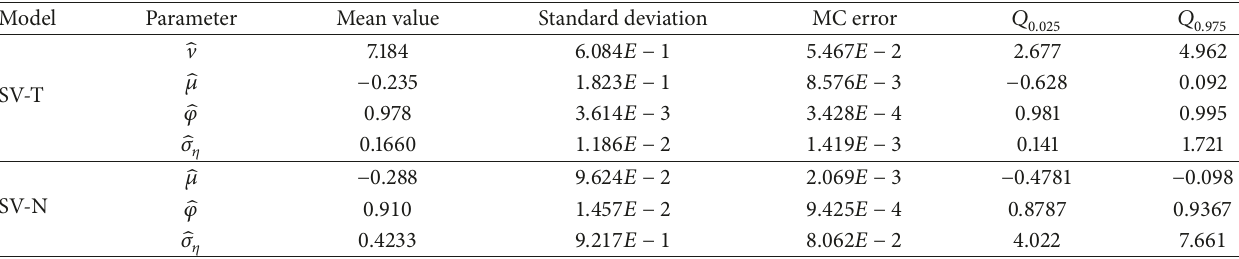
Table 3: SV model parameters estimation results and statistical tests.